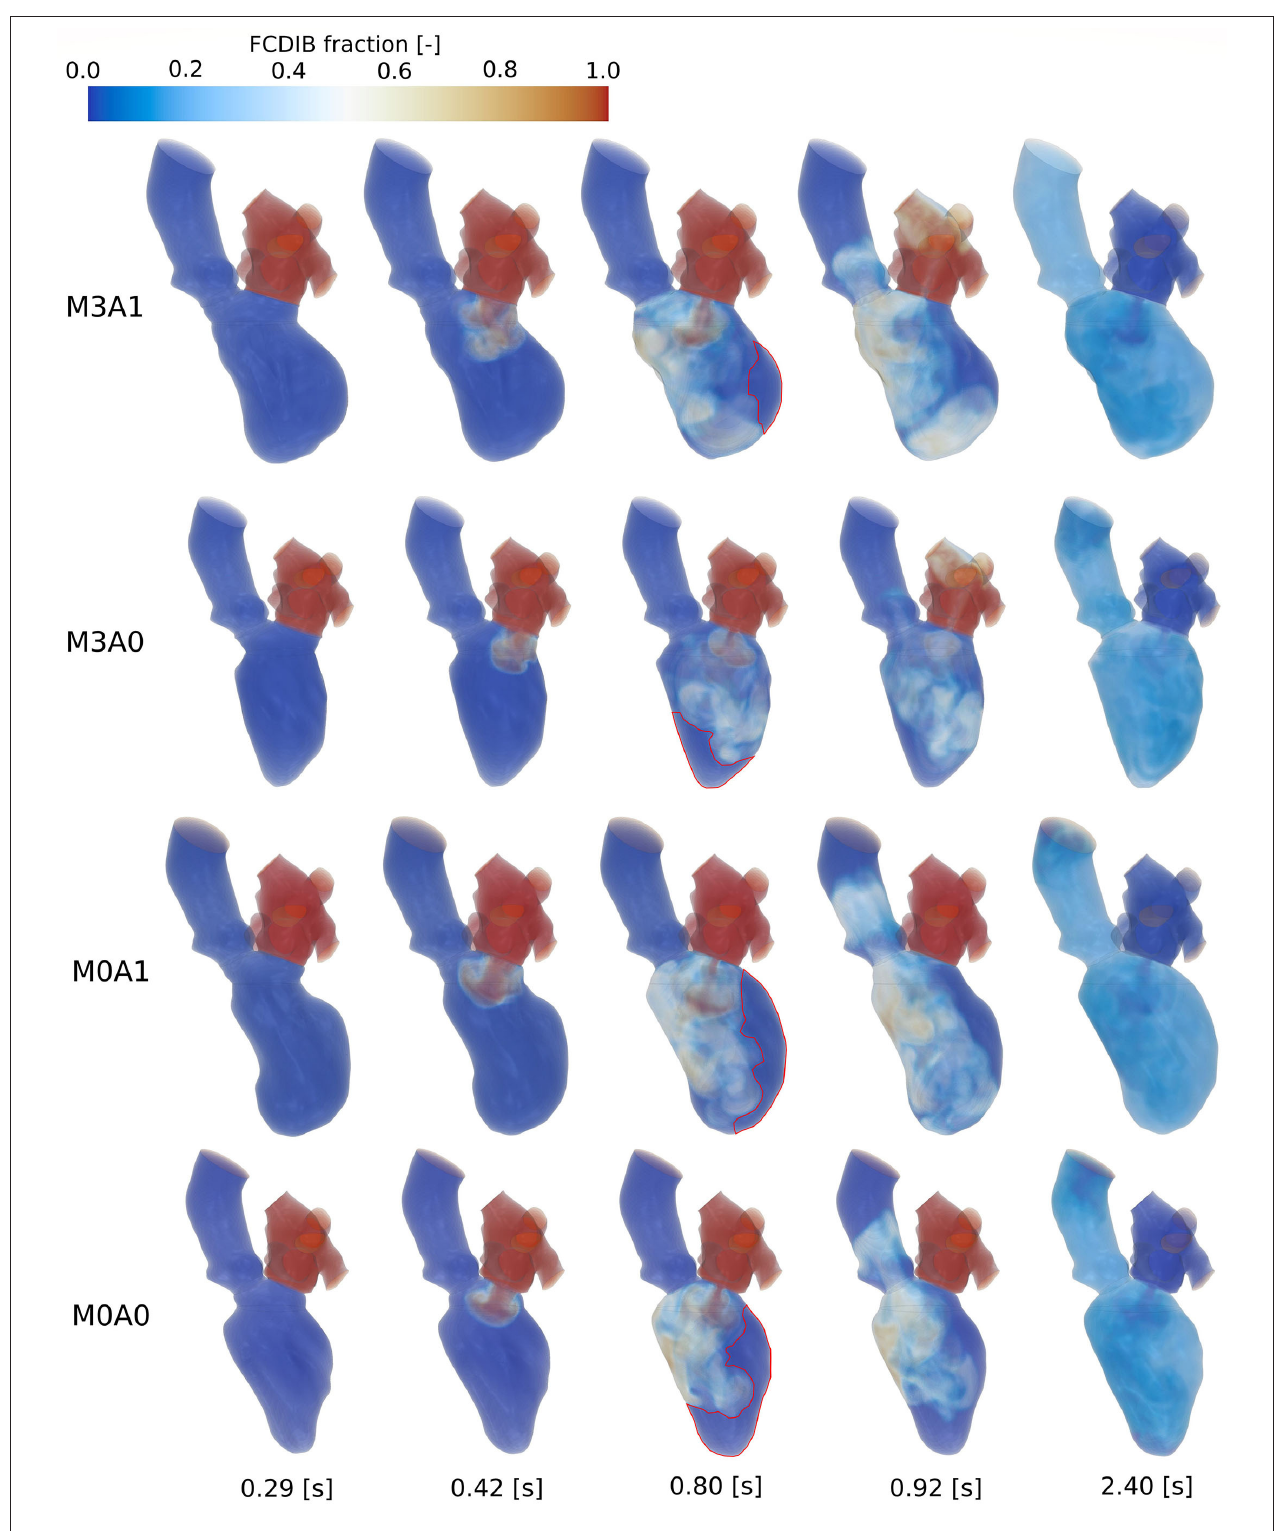
FIGURE 10 | FCDIB for all cases (top to bottom: M3A1, M3A0, M0A1, M0A0) from left to right at end systole of the first cycle (0.29 s), peak E-wave of the first cycle (0.42 s), end diastole of the first cycle (0.8 s), peak systole of the second cycle (0.92 s), and the end of the third cycle (2.4 s). Red contours at end diastole of the first cycle mark regions with poor washout, which are associated with a higher risk of thrombus formation.